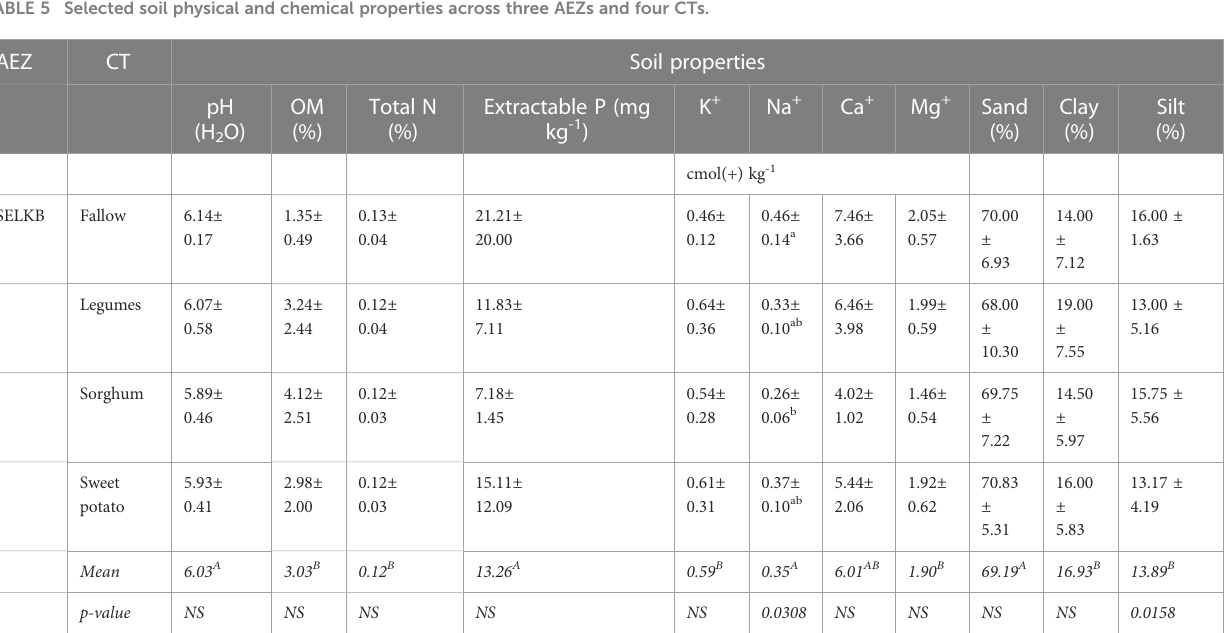
Relative proportion (%) of the AMF across agroecological zones depended on the spore abundance of the identi fi ed genera.